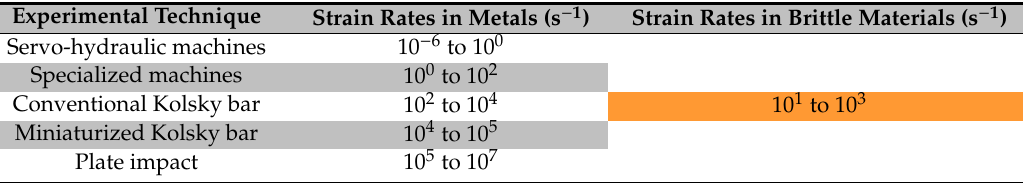
Table 1. Experimental techniques for specific strain